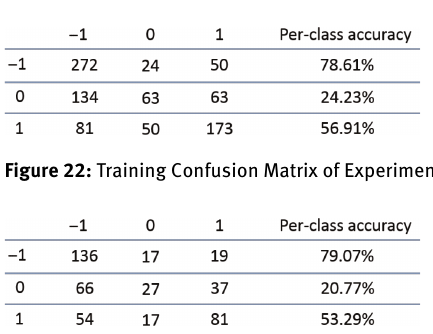
Figure 21: Training Process of Experiment 1.